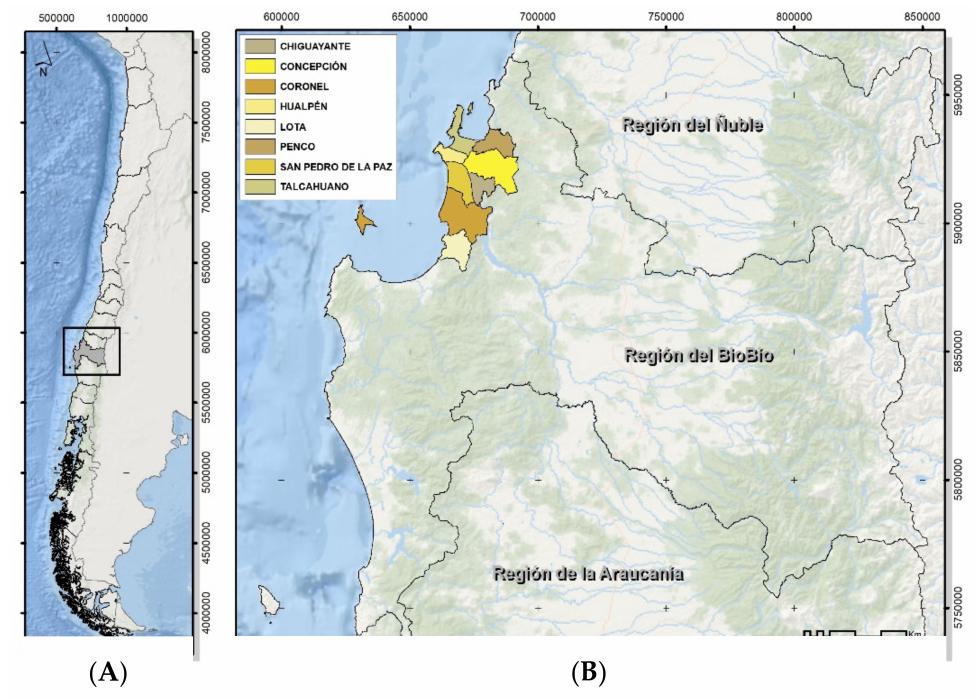
Figure 1. Study area Metropolitan Area of Concepci ó n (MAC) [23]: ( A ) MAC location in the country; ( B ) Map of Biob í o